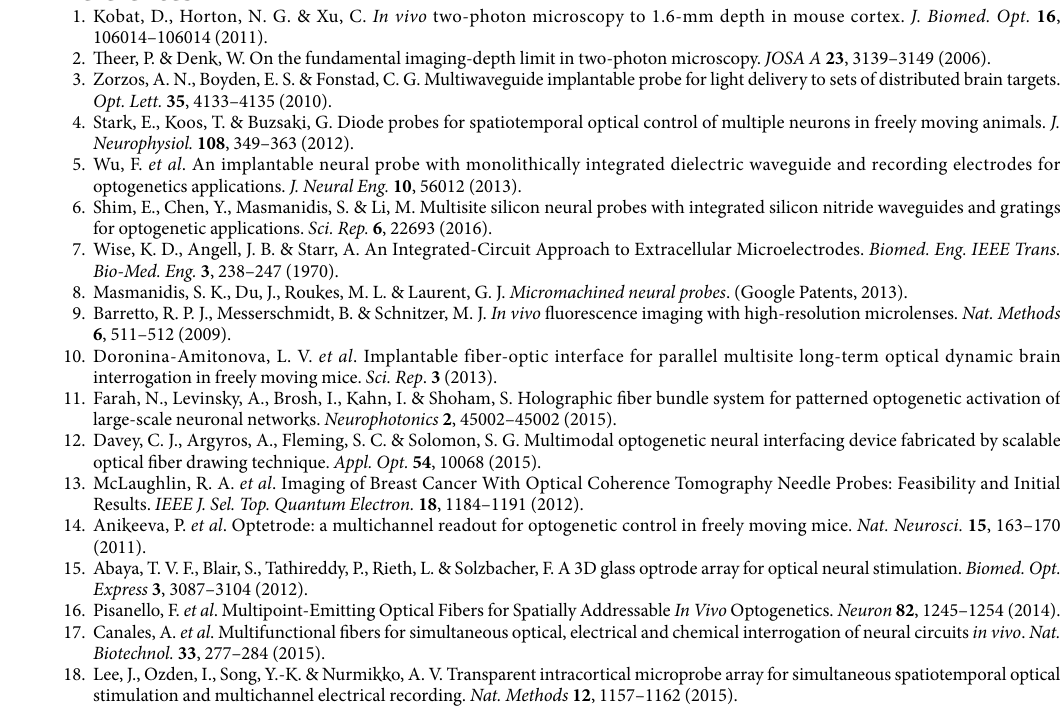
long probe composed of silicon is expected to buckle at a width of approximately 6 microns while the same probe, composed of SiC with the same geometry would not buckle. We assume here a conservative blunt tip geometry, as well as a pinned/fixed boundary condition (K = 2.045) instead of the fixed/fixed boundary condition (K = 4).